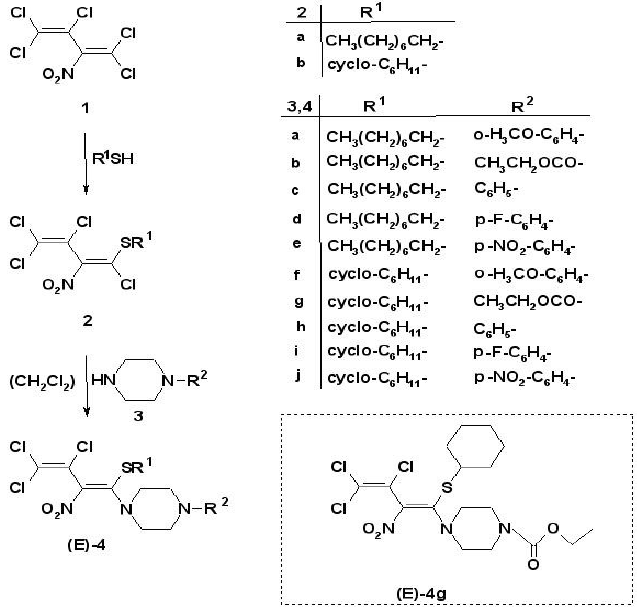
Figure 1. Synthesis of substituted